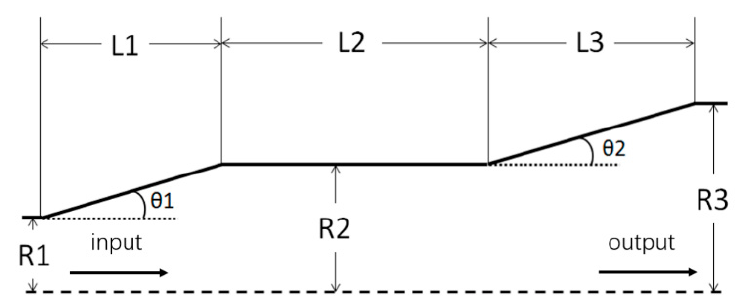
Figure 4. Schematic of the resonator for the 170 GHz gyrotron.